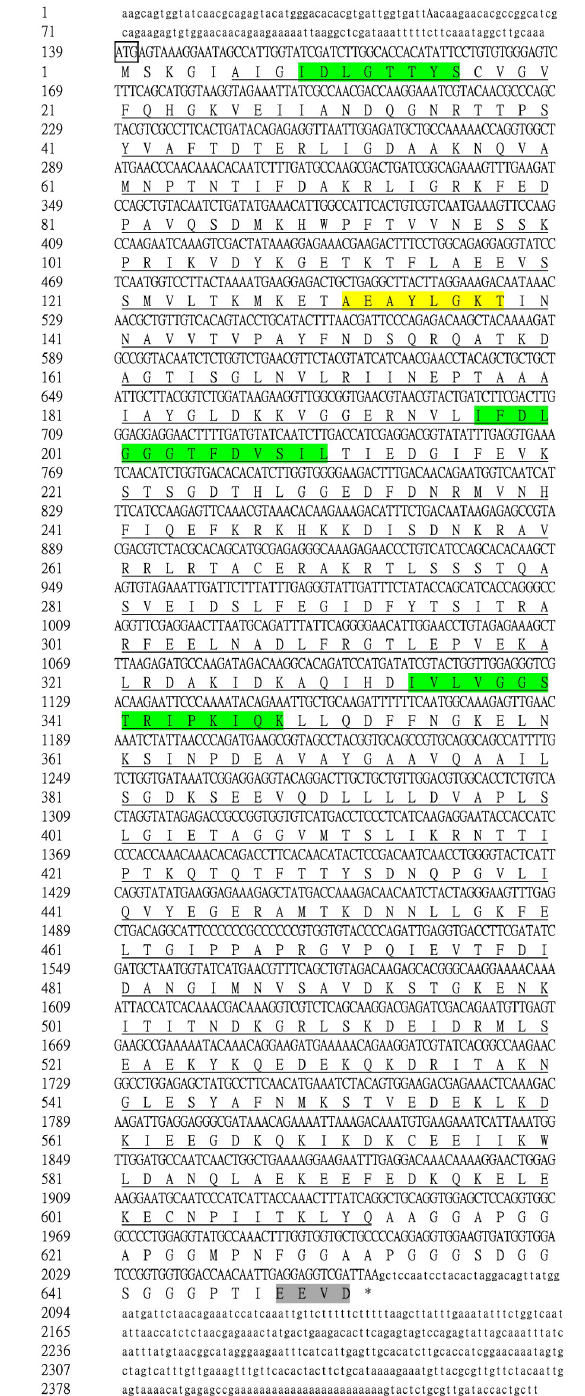
FIGURE 2 | The nucleotide sequence analysis of Pm-HSP70. 5 (cid:48) UTR and 3 (cid:48) UTR are indicated with small letters; The deduced amino acid sequences are indicated with capital letters; The start codon in the 5 (cid:48) -UTR was in a box and the stop codons (TAA) was indicated with an asterisk ( ∗ ). Three signatures were green background; a putative ATP-GTP binding site was yellow background; the cytoplasmic characteristic motif was gray background and the underlined indicates the HSP70